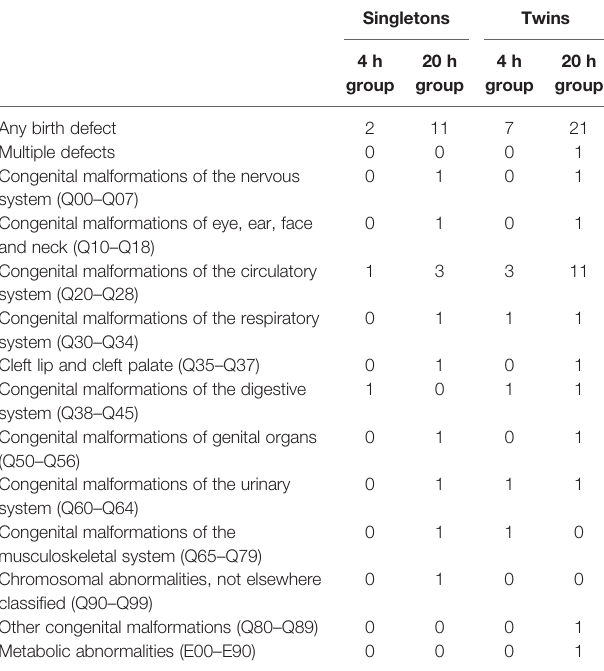
TABLE 4 | Types of congenital malformations among live-born